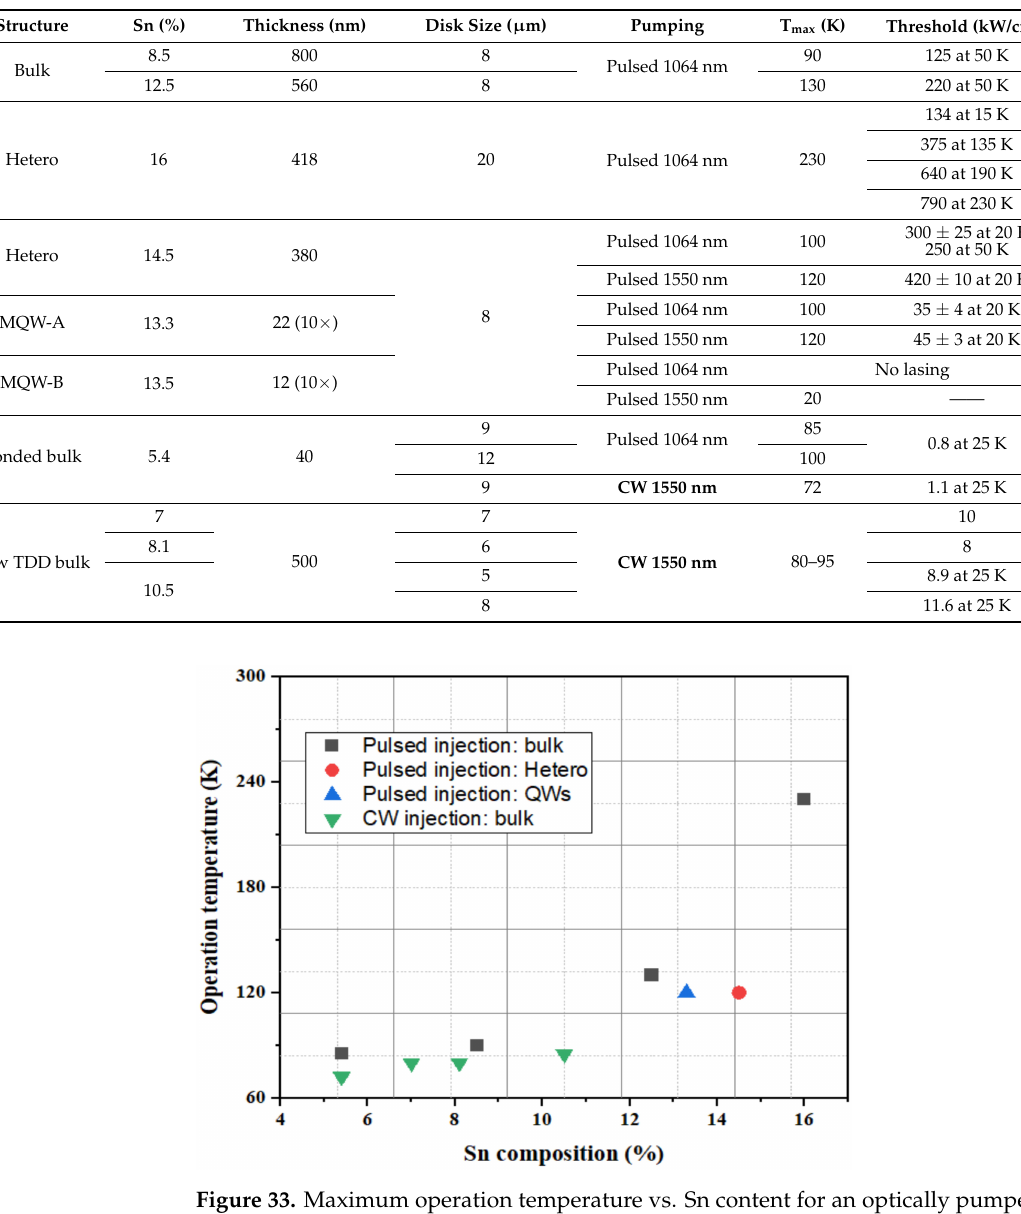
Table 7. Summary of the reported optically pumped WGM cavity GeSn lasers in terms of structure, Sn content, thickness, disk size, pumping laser, maximum operation temperature (T max ), and threshold.